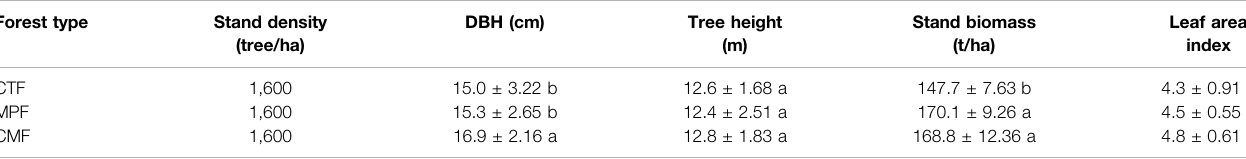
TABLE 1 | Stand characteristics of the three examined subtropical forest types in the study site. Forest type Stand density (tree/ha)